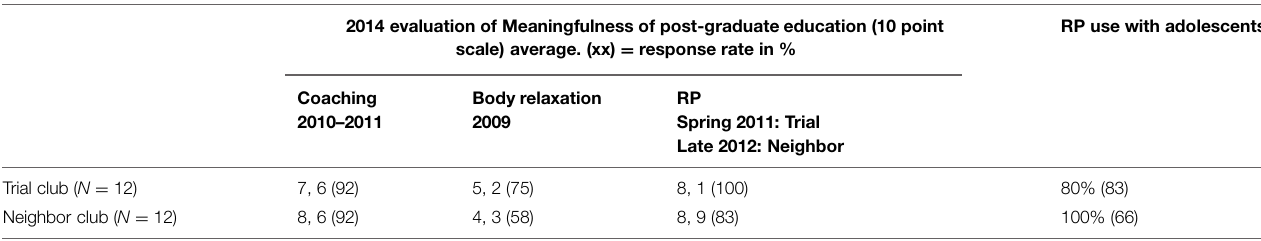
TABLE 3 | Staff evaluation of the meaningfulness of three educations, and their specific use of the RP program with adolescents in the